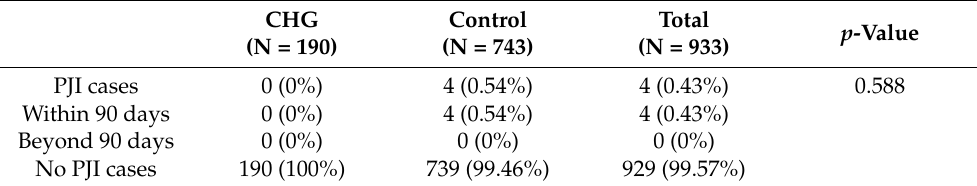
Table 4. The periprosthetic infection rate of primary THA between